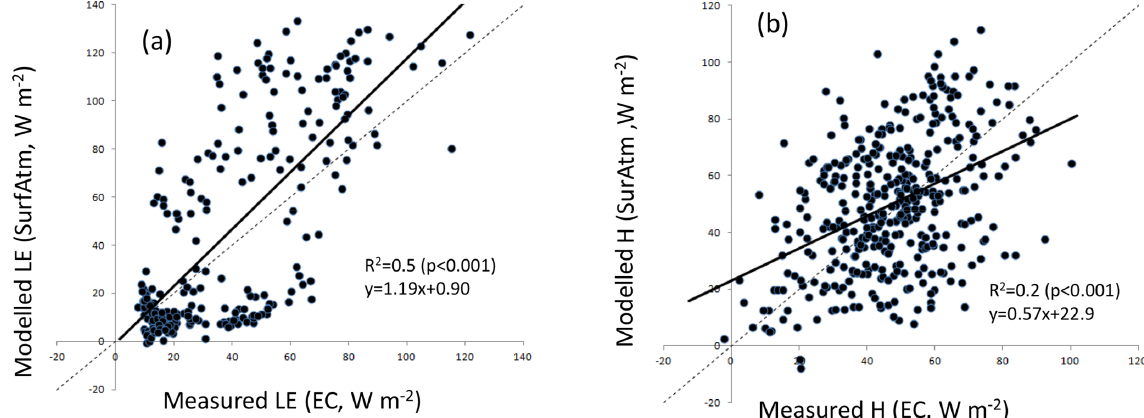
Figure 3. (a) Daily modelled latent heat flux in Surfatm vs. daily measured latent heat flux, in watts per square metre; (b) daily modelled sensible heat flux in Surfatm vs. daily measured sensible heat flux, in watts per square metre. The thick black line is for the linear regression, and the dashed black line is the 1 : 1 line. Available measured EC data are more numerous for H than for LE due to the criteria applied by the post-processing (see Supplement of Tagesson et al., 2015b).